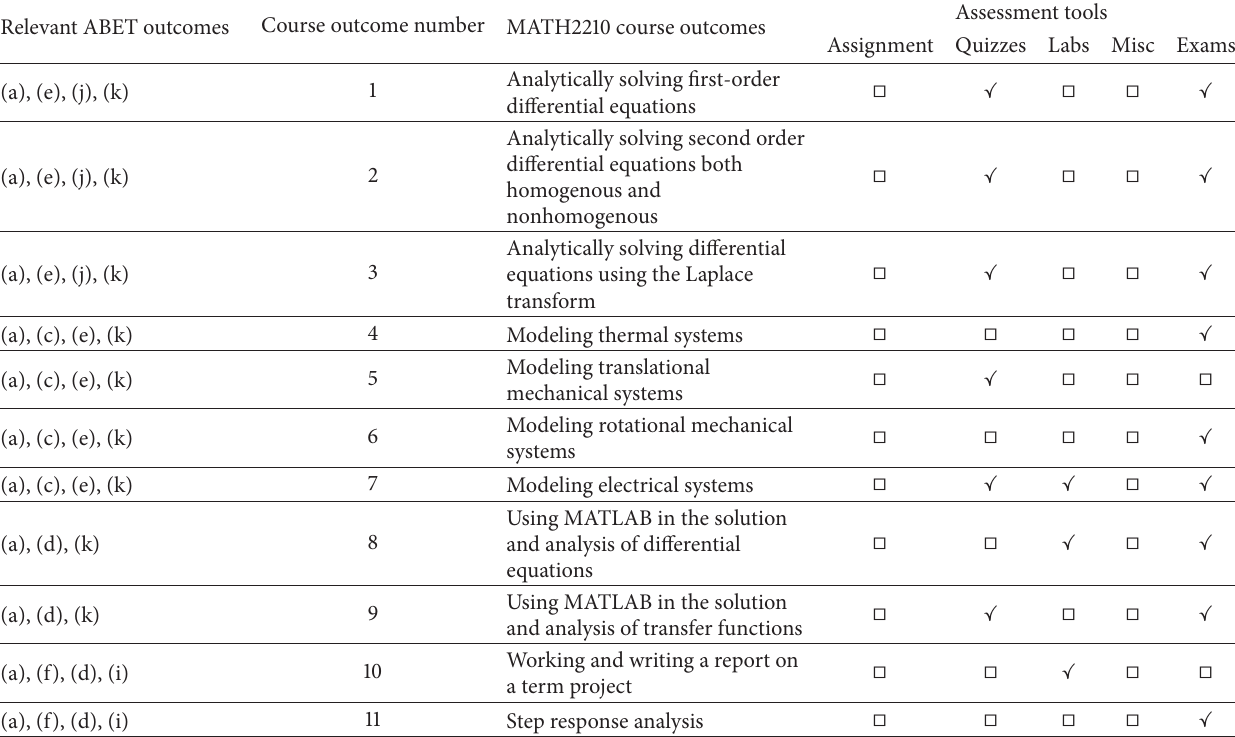
Table 3: Course outcomes, mapping with ABET and students direct assessment tools for the course MATH2210-differential equations and engineering